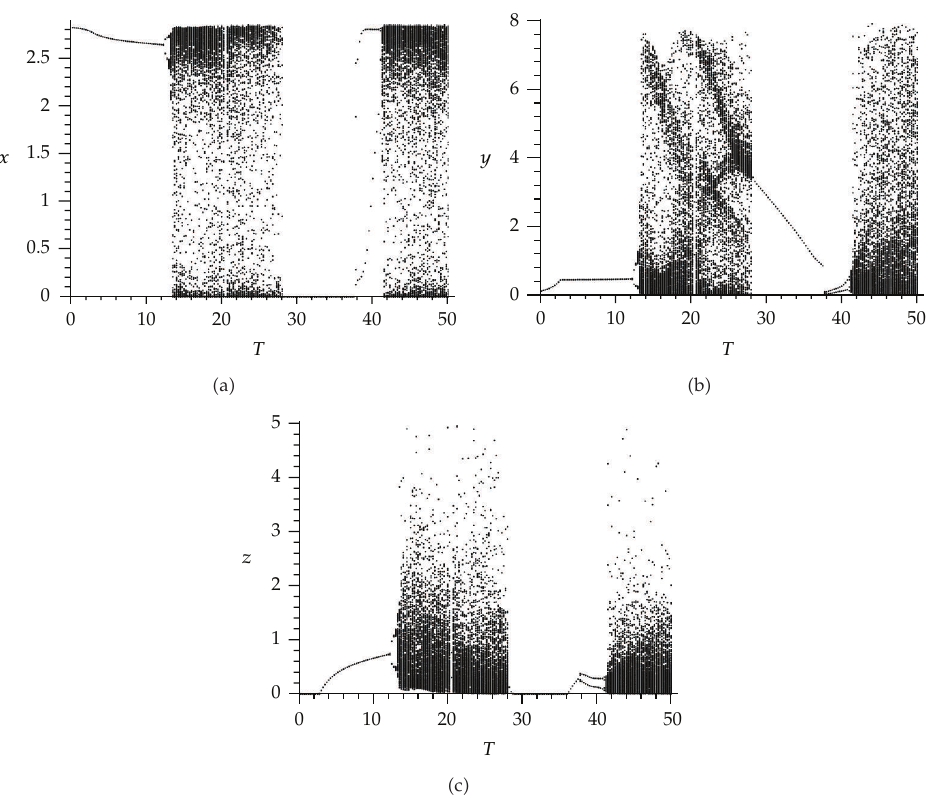
Figure 1: Bifurcation diagram of system (cid:5) 1.3 (cid:6) with initial conditions x (cid:5) 0 (cid:6) (cid:7) 0 . 1, y (cid:5) 0 (cid:6) (cid:7) 0 . 1, z (cid:5) 0 (cid:6) (cid:7) 0 . 1, and 0 ≤ T ≤ 50; a (cid:7) 1 . 85, b (cid:7) 0 . 65, c 1 (cid:7) 0 . 65, c 2 (cid:7) 0 . 55, c 3 (cid:7) 0 . 45, c 4 (cid:7) 0 . 15, c 5 (cid:7) 0 . 55, c 6 (cid:7) 0 . 8, e 1 (cid:7) 0 . 6, e 2 (cid:7) 0 .